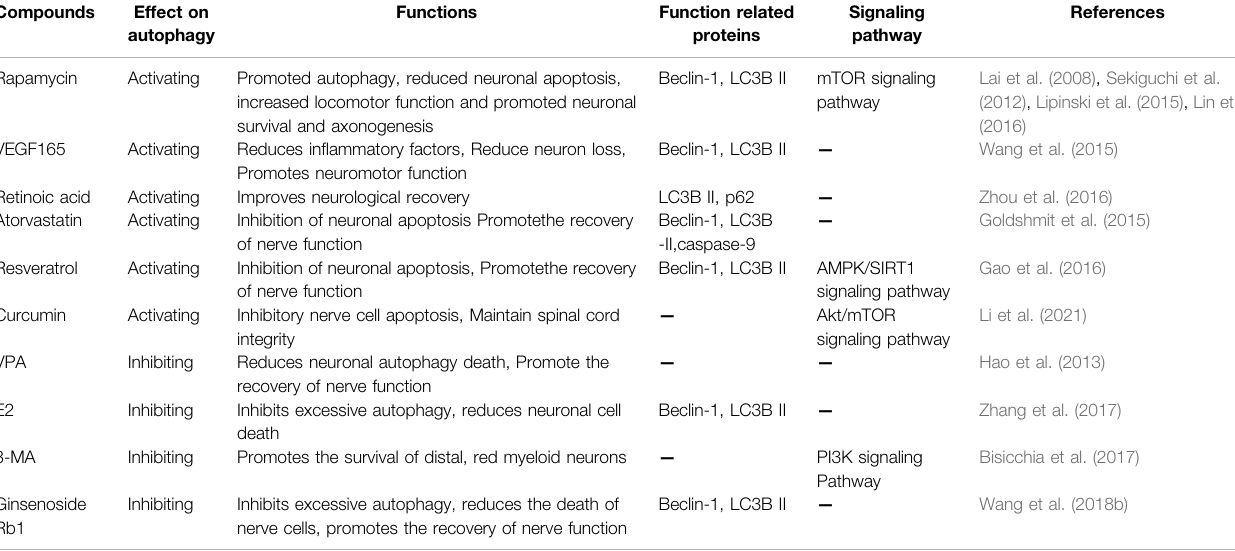
TABLE 3 | Maincompounds directed towards autophagy for the treatment of SCI.